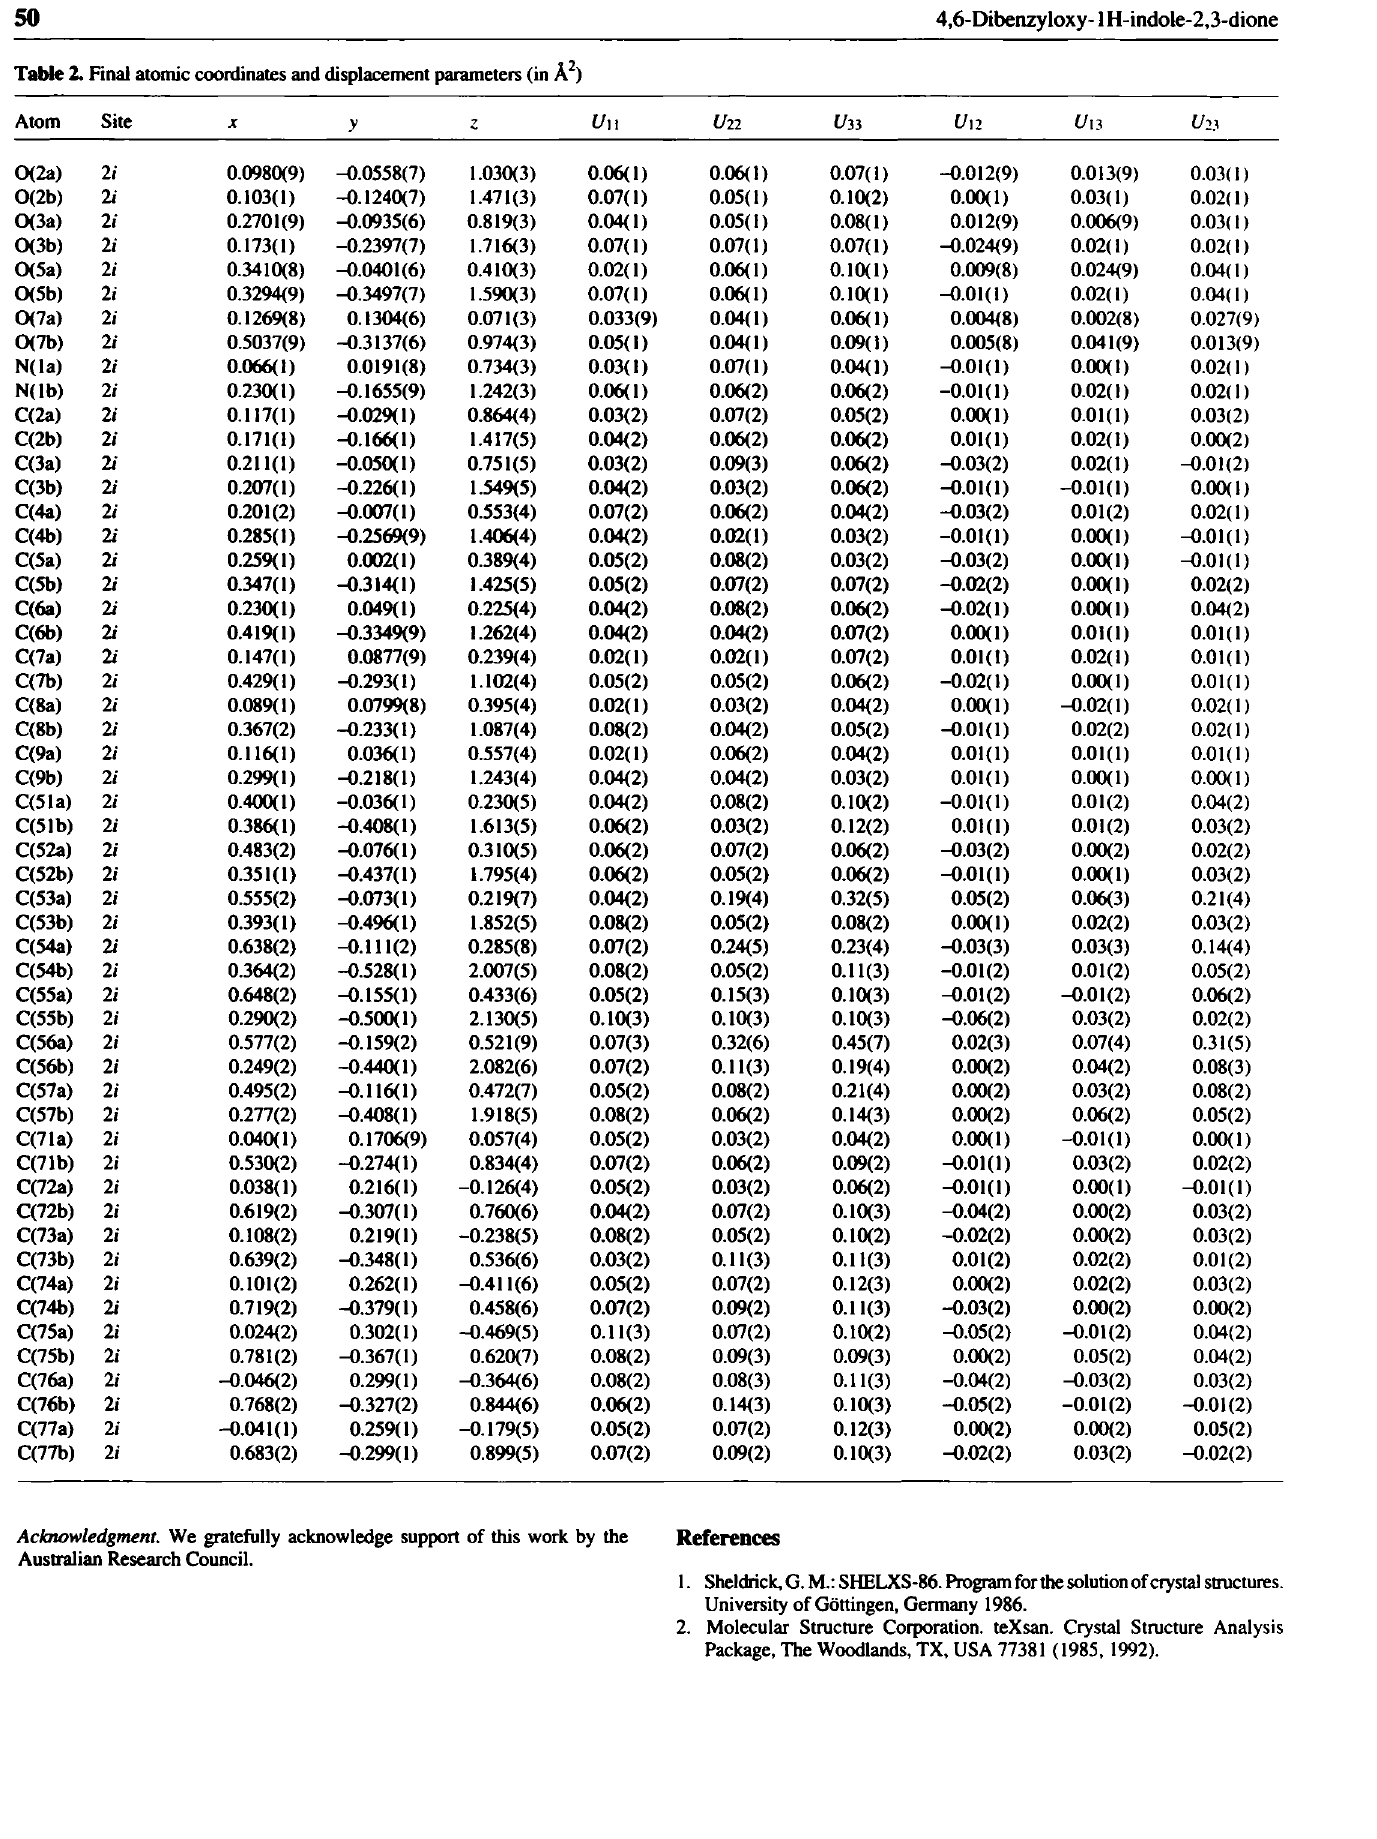
Table 2. Final atomic coordinates and displacement parameters (in Â 2